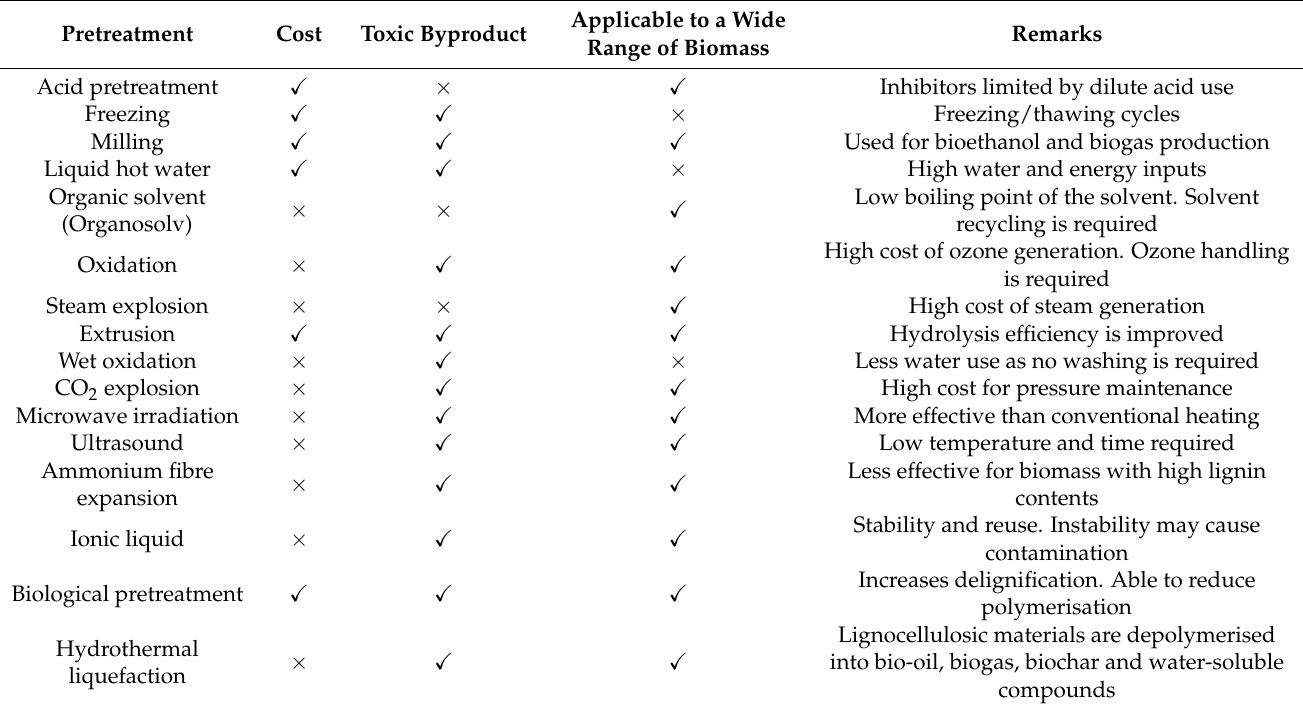
Table 5. Comparison of the different pretreatment methods used for lignocellulosic degradation methods. Good or bad performance regarding cost, toxic byproduct formation and applicability are marked by (cid:88) and × , respectively